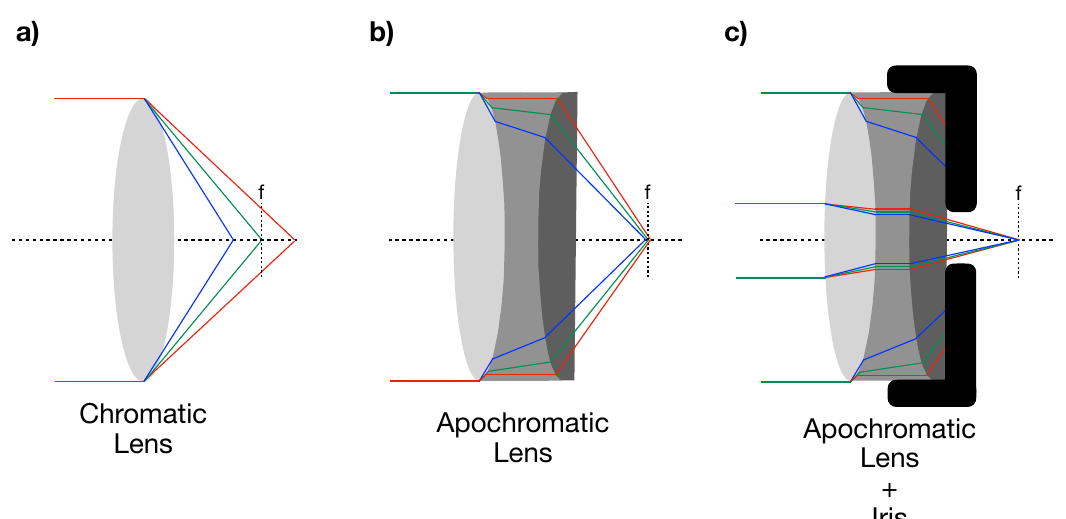
Figure 4. Comparison between the wavelength-dependent focusing obtained with ( a ) chromatic, ( b ) apochromatic and ( c ) apochromatic combined with iris lenses. The use of apochromatic lenses massively reduces the chromatic aberration observed with standard chromatic lenses. However, the remaining aberration caused by the lenses geometry can only be minimized by reducing the numerical aperture, and therefore, by collecting the signal only using the part of the lens closer to the optical axis (less affected by